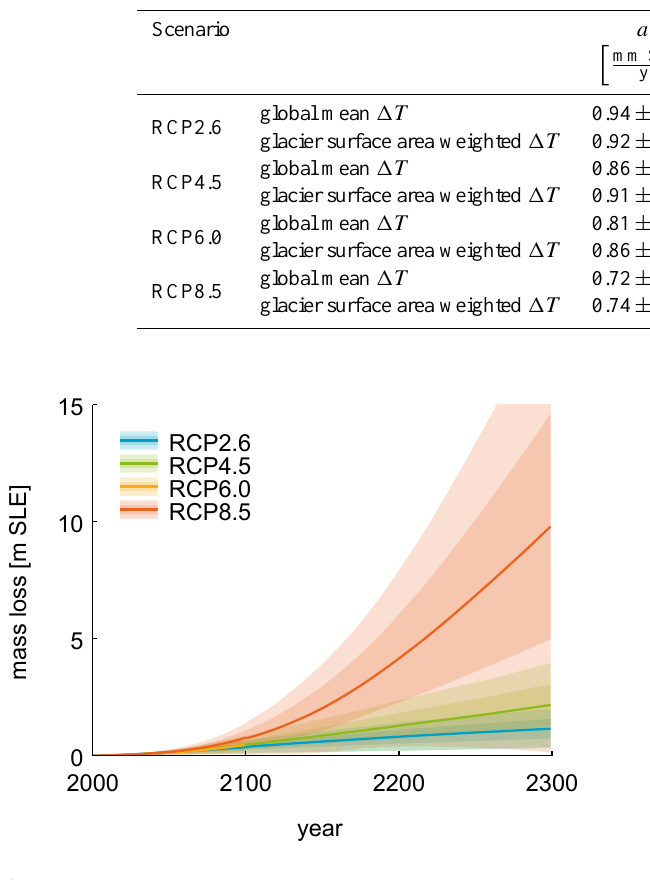
Fig. 8. Global glacier-mass loss of Marzeion et al. (2012) vs. global glacier-mass loss when glacier hypsometry is held constant, and ice volume treated as infinite. Black line is the bisector. Colors as in Fig. 2. Different panels refer to different